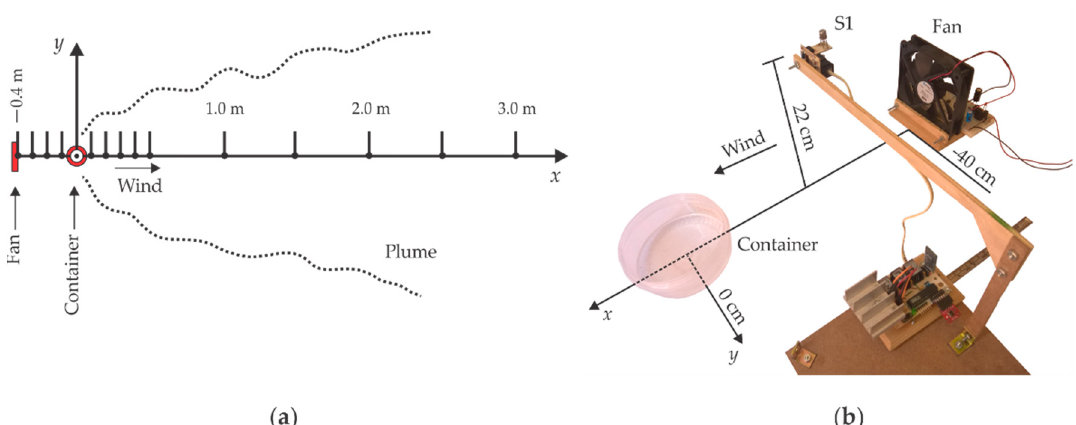
Figure 7. ( a ) Diagram of the 15 sampled concentration points along x -axis at height z 0 = 22 cm; ( b ) Setup to find the concentration profile at a height of z 0 = 22 cm by scanning a total distance of 3.4 m on the x -axis using Sensor 1. The fan-container arrangement that generates the gas plume can be observed. Sensors 2018 , 18 , x FOR PEER REVIEW 11 of 16